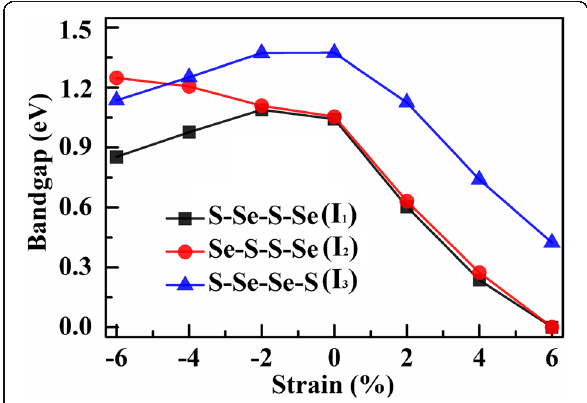
Fig. 5 The bandgap ( E g ) versus the applied strains for the I 1 , I 2 , and